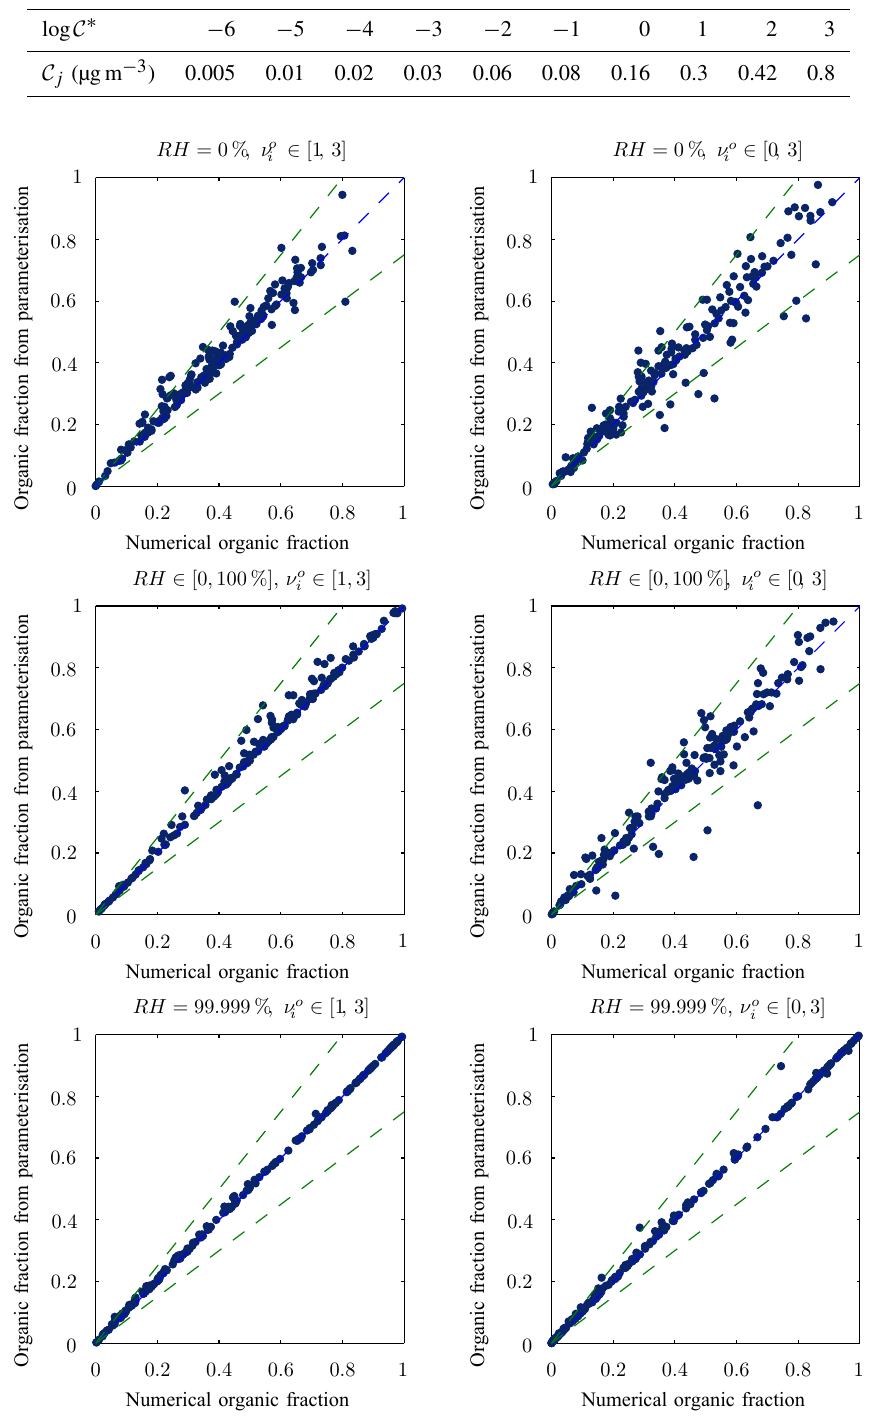
Figure 5. Comparison of the organic mass fraction from the leading-order solution against that calculated using the non-linear solver for randomly chosen parameters from Table 1. SVOC concentrations are obtained by randomly rescaling the volatility distribution in Table 2 by a random factor between 0 and 100. The solution is calculated for between two and six modes, and only the organic mass fraction of the first mode is plotted. The 25% error margins are shown by the dashed green